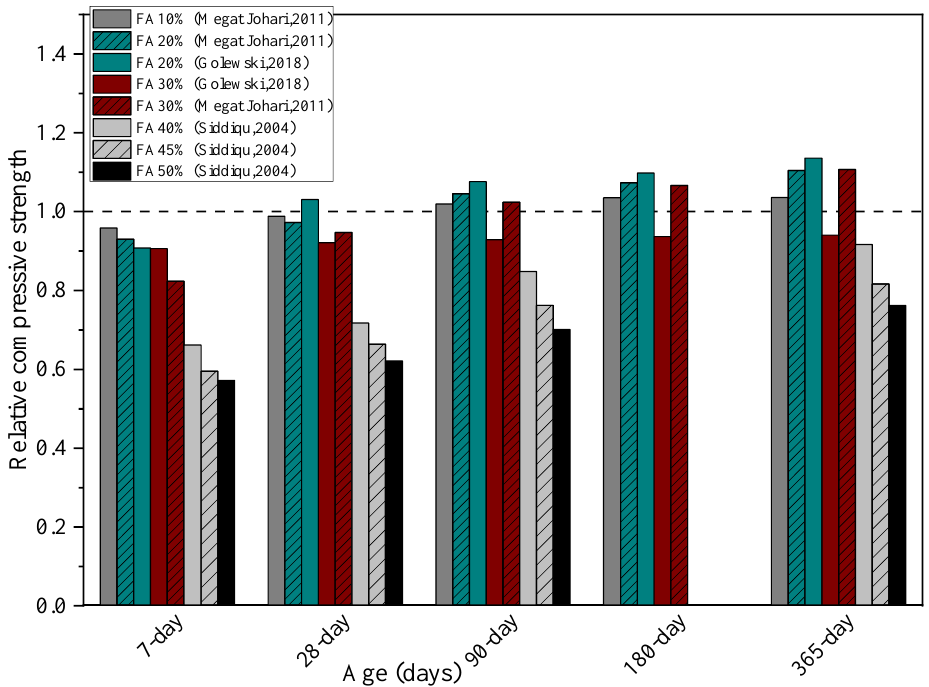
Figure 5. Relativecompressivestrengthofconcretecontainingflyash(FA)atvariouscuringages[23,24,26]. Figure 5. Relative compressive strength of concrete containing fly ash (FA) at various curing ages [23,24,26]. 2.3.2. Splitting Tensile